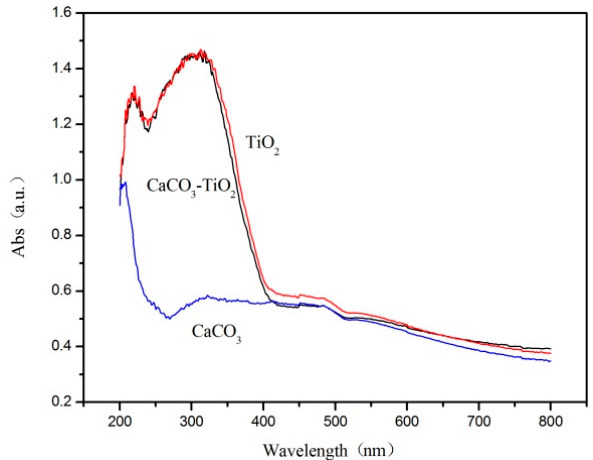
Figure 5. UV-VIS absorption spectra of CaCO 3 , TiO 2 and CaCO 3 –TiO 2 .